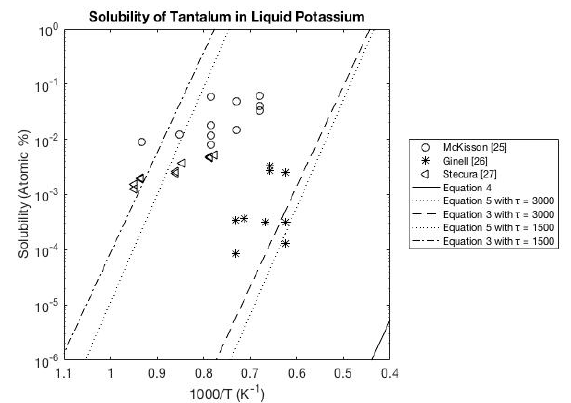
Figure 7. Solubility of tantalum in liquid potassium.